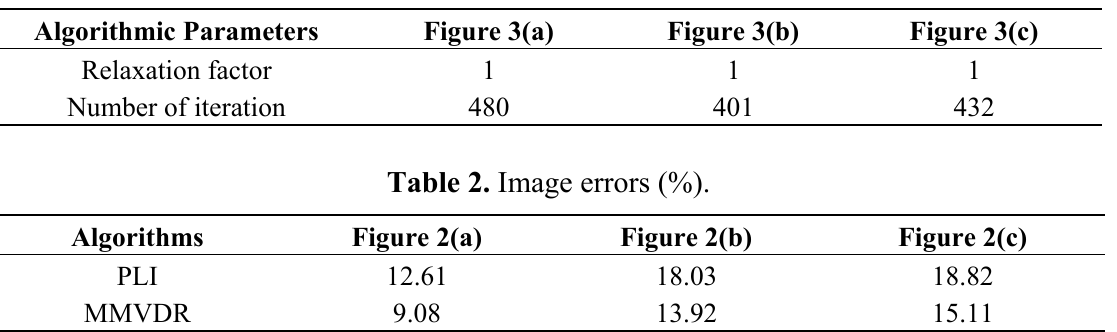
Table 1. Algorithmic parameters for the PLI algorithm.